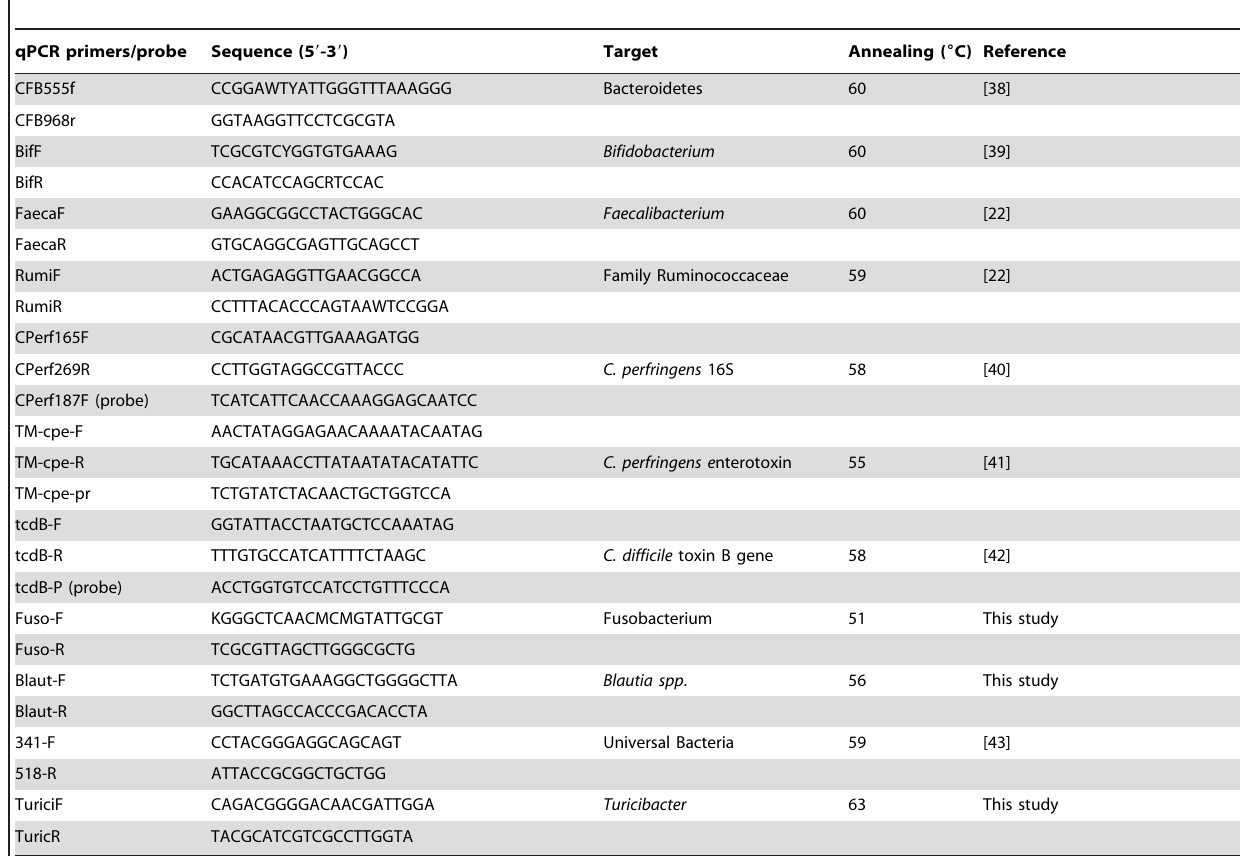
Table 2. Oligonucleotides primers/probes used in this